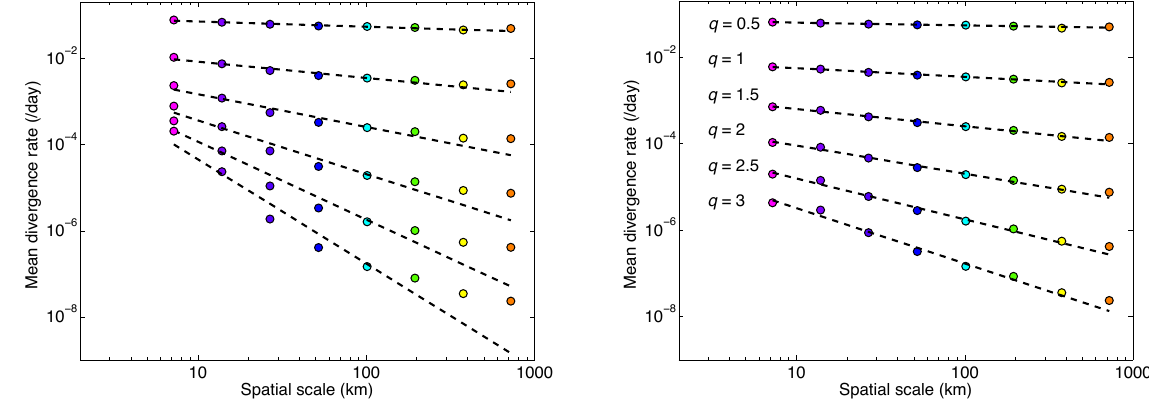
Figure 11. Multifractal analysis: moments of the absolute divergence rates (cid:104)|˙ (cid:15) div | q (cid:105) as a function of the scale L for q = 0 . 5 to 3, from the unfiltered (left panel) and filtered (right panel) composite deformation field for the period 2–10 February 2007. Dashed lines are power-law fits of the first six values (here, from 7 to 200km).